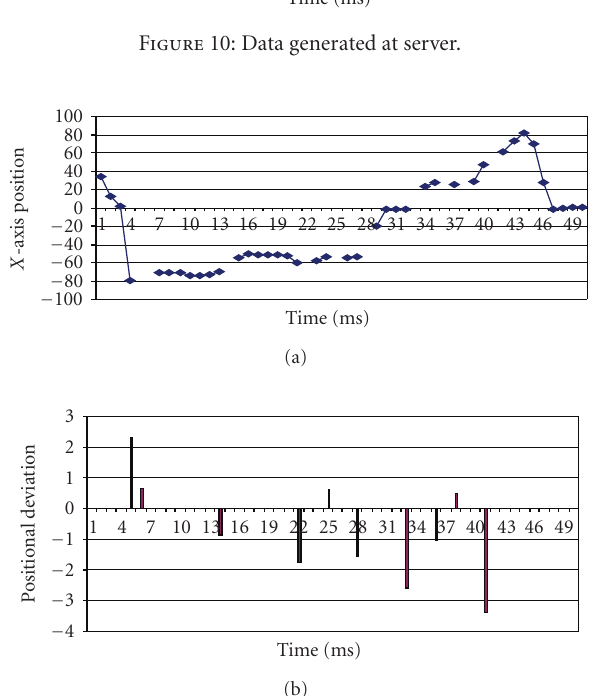
Figure 11: (a) Data received at client (20% loss) unsynchronized. (b) X-Axis positional deviation (20% Loss)